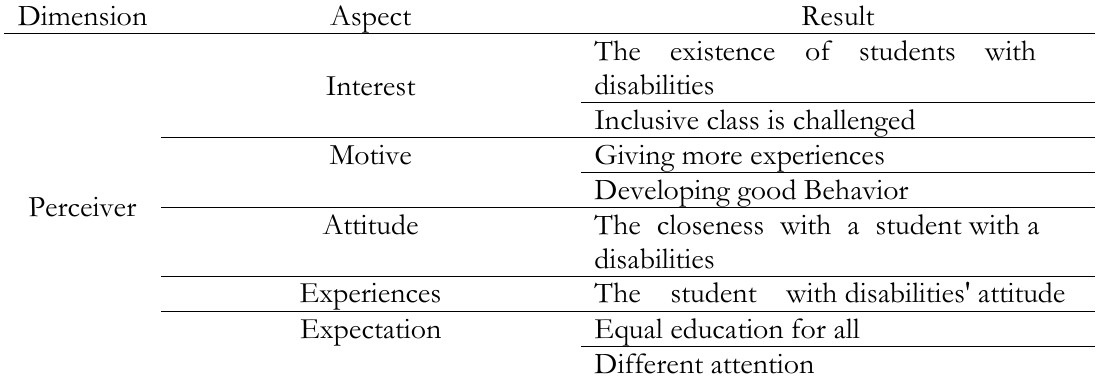
TABLE 1 . Student's Perception toward the Implementation of Inclusive Education